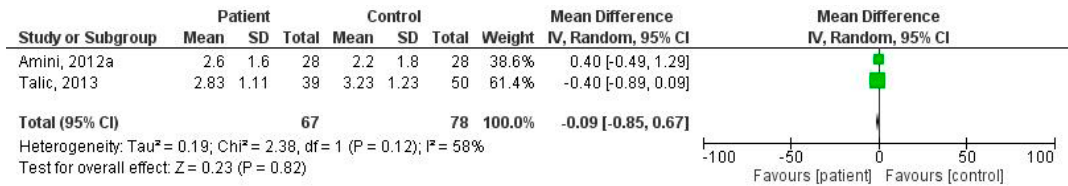
Figure 6. Forest plot of the random effect of salivary chromium levels in patients under fixed orthodontic treatment in case-control studies.